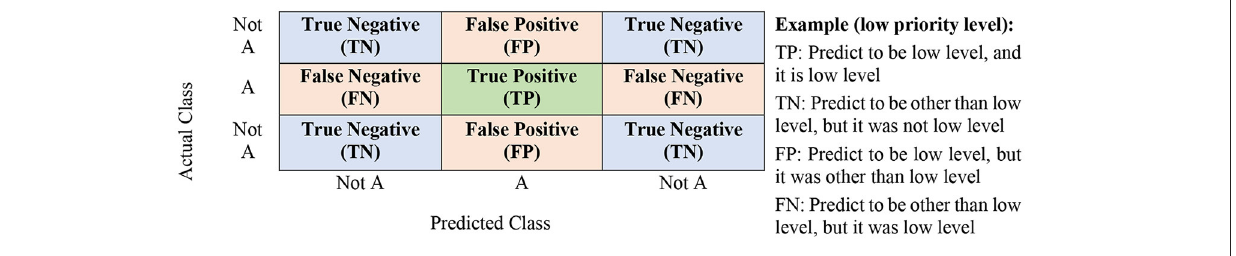
FIGURE 2 | Confusion